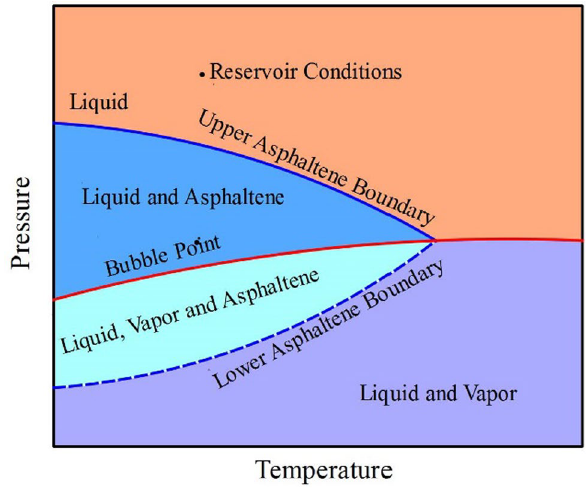
Fig. 2 Risk of asphaltene precipitation as a function of difference between the initial pressure and bubble point pressure as well as the reservoir fluid density (de Boer et al.